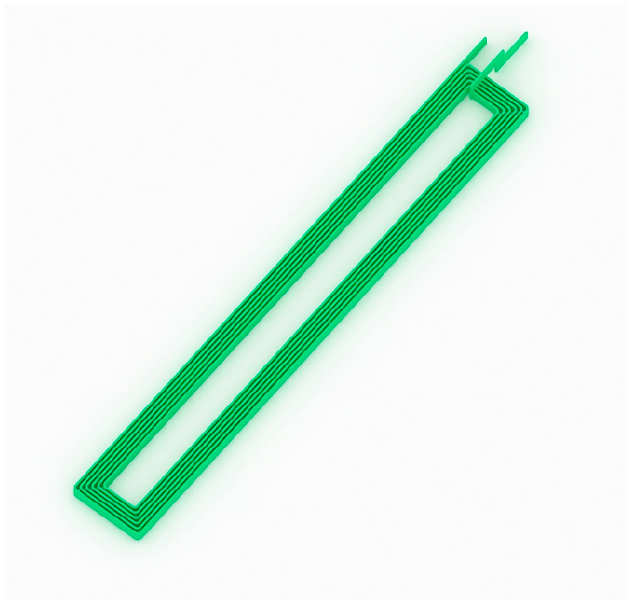
Figure 5. The inductors, with a size of 14.88 × 2 mm 2 , are simulated onto a substrate of 525 μ m of silicon +1 μ m of silicon dioxide. silicon +1 µ m of silicon